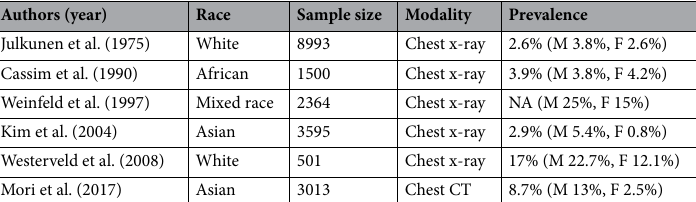
Table 3. Previous studies reporting the prevalence of T-DISH. T-DISH thoracic diffuse idiopathic skeletal hyperostosis; CT computed tomography, M male; F